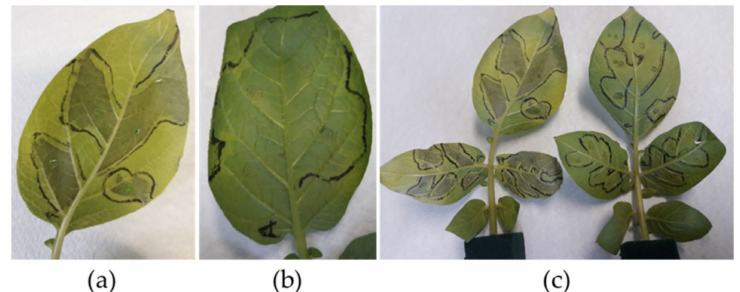
Figure 2. The Avr4 effector agroinfiltration discriminates potato plants with ( a ) or without ( b ) R4 gene. ( a ) Leaflets displaying hypersensitive response after agroinfiltration of Avr4 effector gene. ( b ) Leaflets without R4 gene showing no response after agroinfiltration of Avr4 effector gene. ( c ) Leaves with hypersensitive response ( left ) compared to leaves agroinfiltrated with empty vector, mock control ( right ).